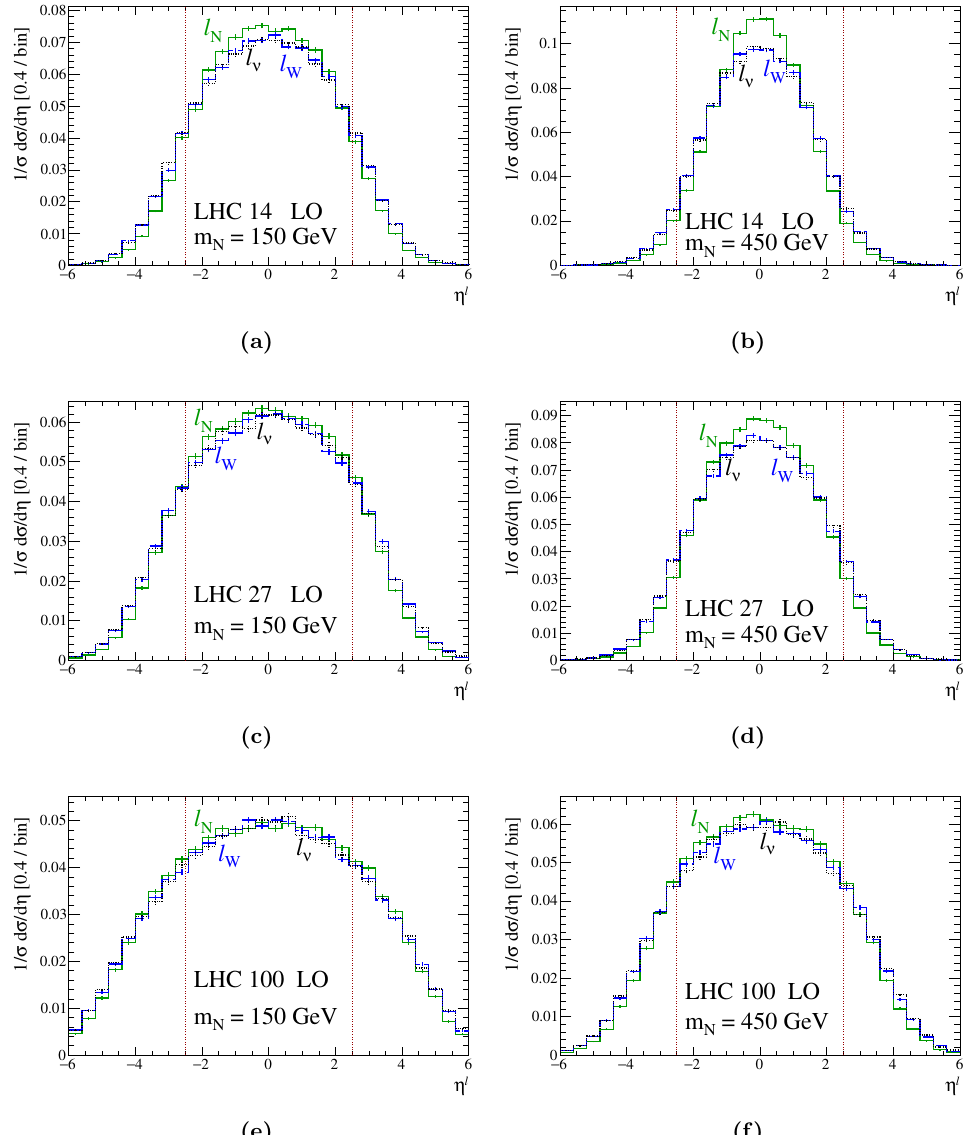
Figure 7. Same as (cid:12)gure 6 but for pseudorapidity ( (cid:17) ) of the charged